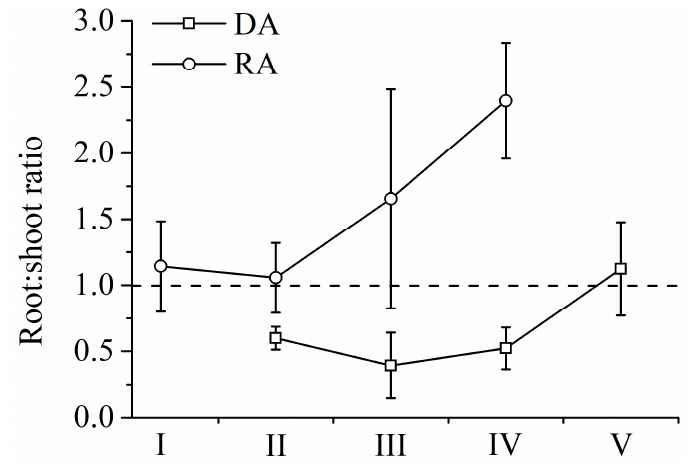
Figure 6. Root/shoot ratio of R. aureum and D. angustifolia under five encroachment levels.